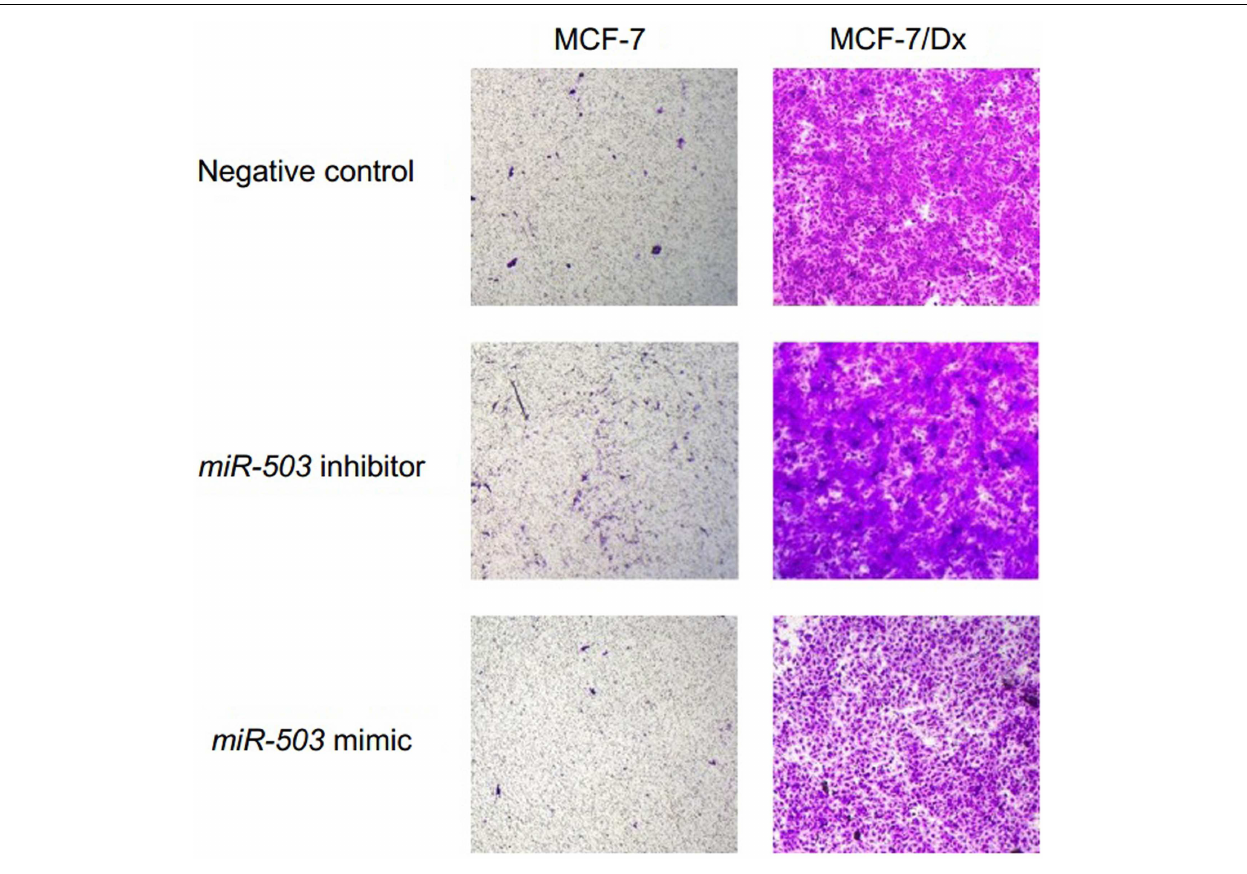
inhibition or mimicry of miR-503 on this capacity. Invasion of cells through a Matrigel ® layer to the underside of transwell membranes was assessed after 48h. Data was representative of at least three independent